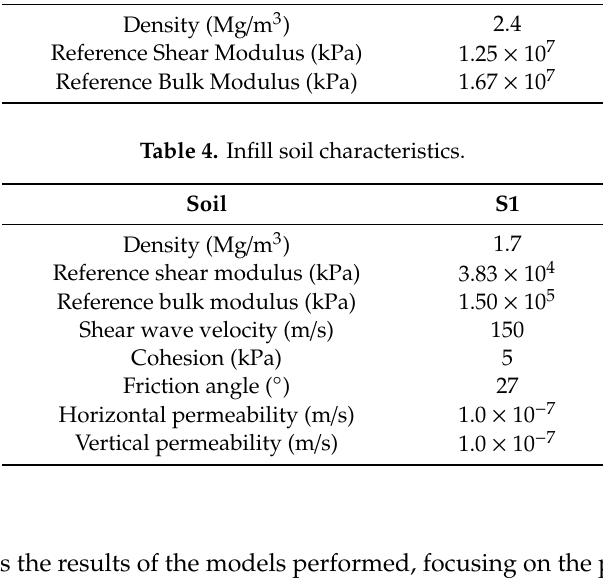
Table 3. Foundation.